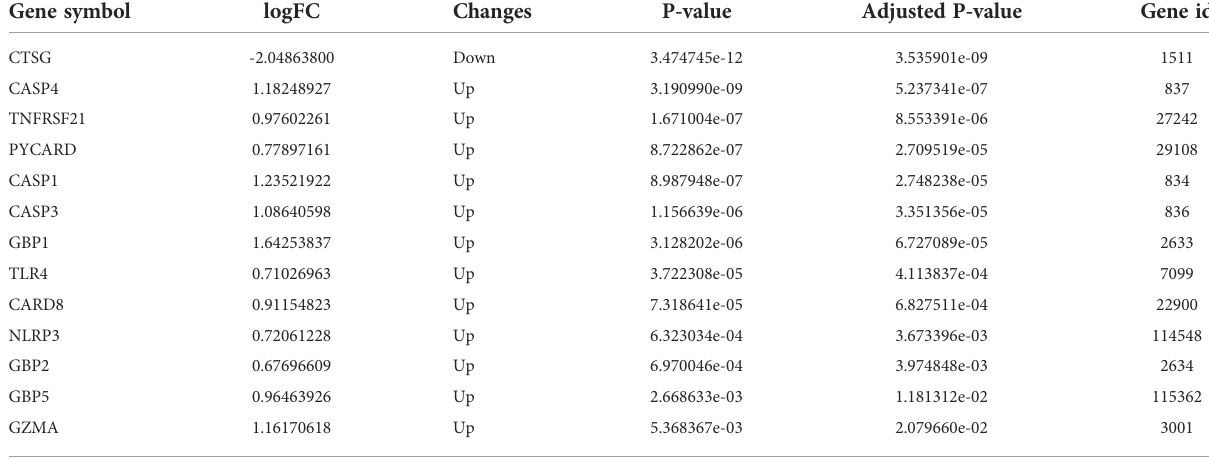
TABLE 2 The 13 differentially expressed pyroptosis-related genes in diabetic retinopathy samples compared to normal